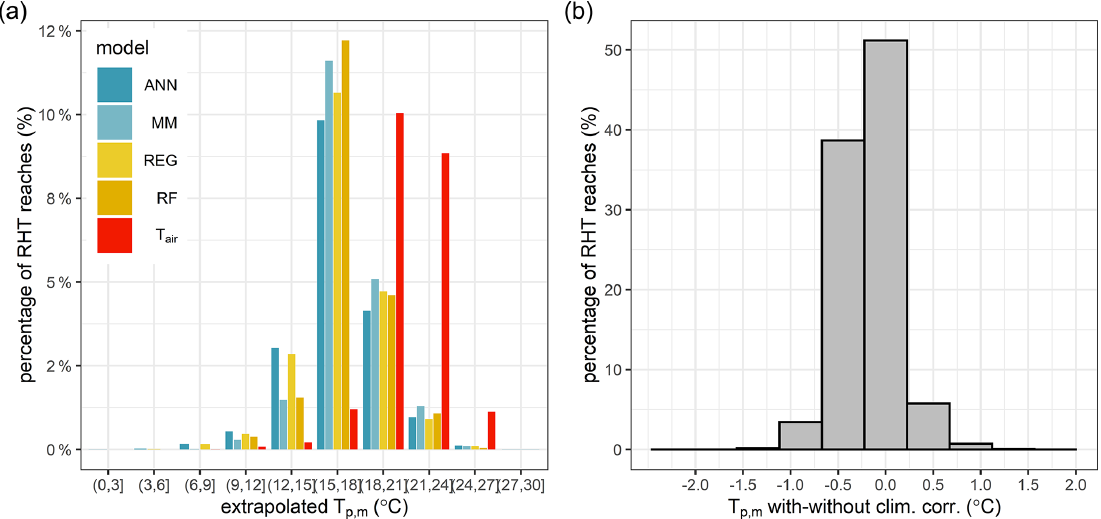
Figure B4. Distributions of T p , m extrapolated to all RHT network reaches. (a) Histogram of models (10 bins equally spaced between 0 and 30 ◦ C) according to their extrapolated T p value, colored by model, and (b) differences between T p , m calculated with and without climate corrections on the 1630 stations with gaps in their data.